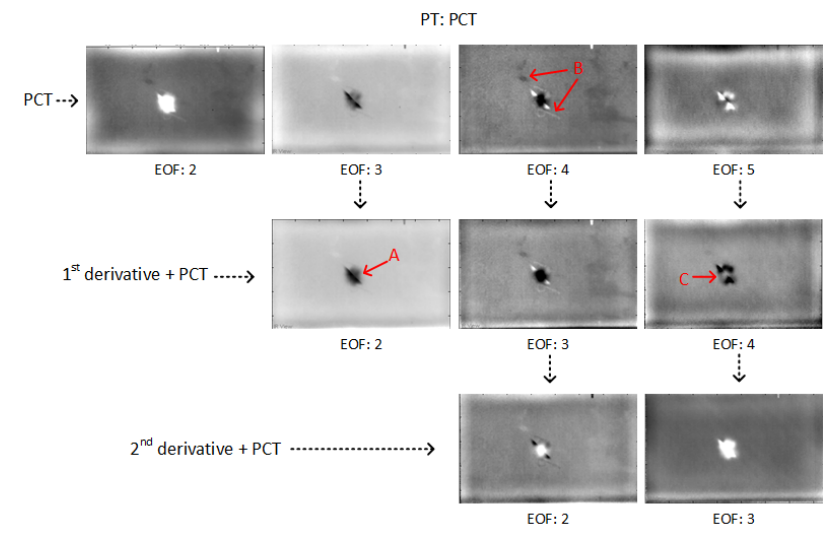
Figure 5. PCT results in PT for CFRP 01.